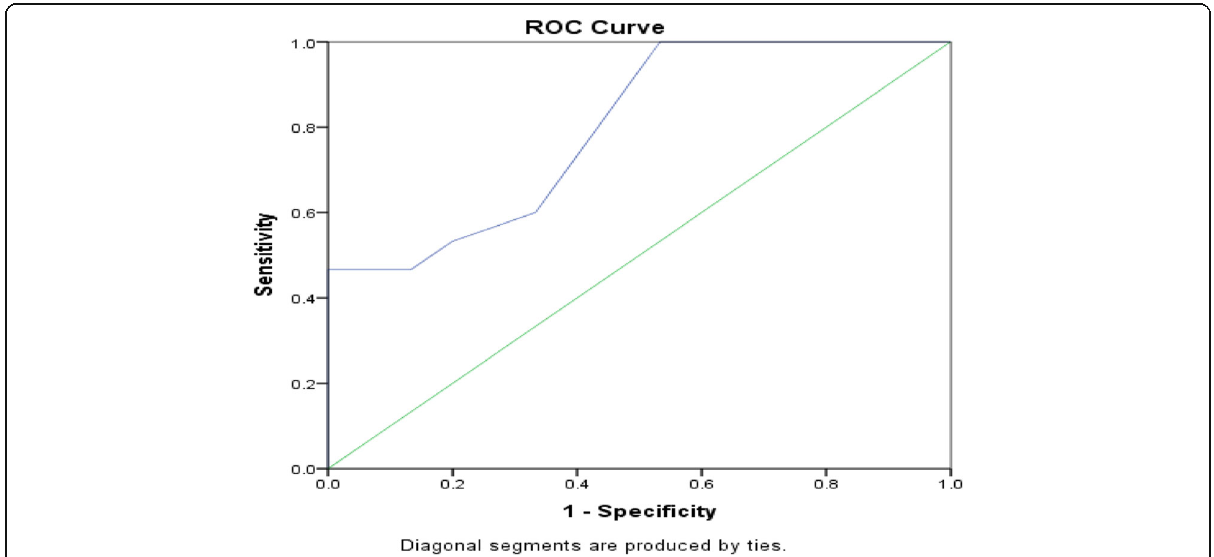
Fig. 1 Receiver operating characteristic curve (ROC) shows that the sensitivity and specificity of the high-sensitivity C-reactive protein (hsCRP) level in discriminating renal transplant recipients with stable allograft function from renal transplant recipients with chronic allograft dysfunction were 73.3% and 60%, respectively, at a cut-off level of 6 mg/l (area under the curve =